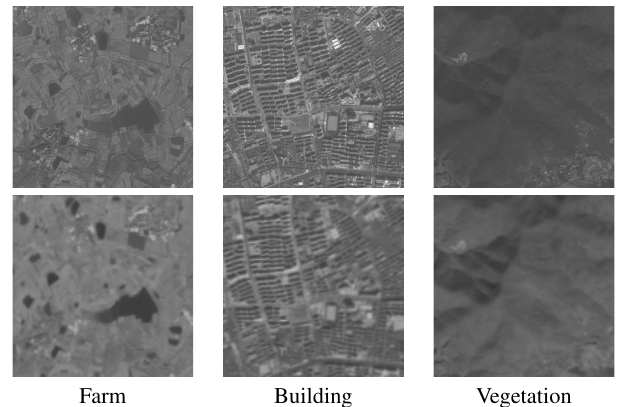
Figure 1: Examples of the SPOT5 image patches taken on Nanjing used for experiments c (cid:13) SPOTIMAGE. Top row: image patches of the the classes with 2.5m resolution ( 512 × 512 pix- els). Bottom row: image patches of the the classes with 10m resolution ( 128 × 128 pixels).